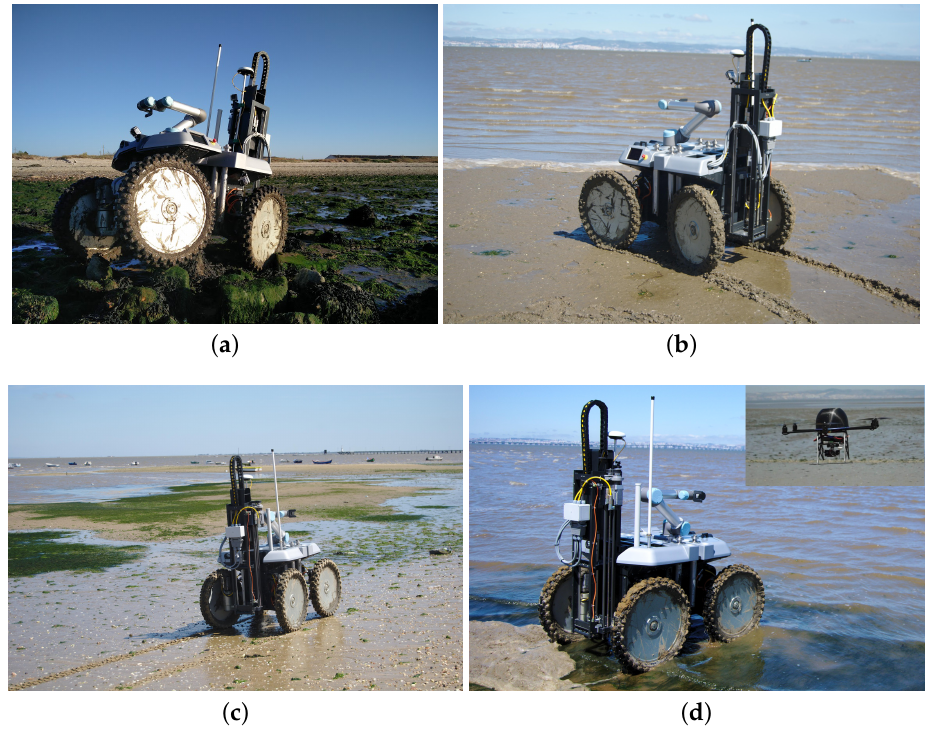
Figure 1. The robotic team in the field trials. The ground vehicle is retrofitted with the drilling tool, which is recharged by a six-DOF arm. The aerial vehicle is equipped with a high resolution camera whose pose is controlled with an active gimbal. ( a ) The ground vehicle over irregular terrain. A passive longitudinal axle allows the robot to follow the terrain’s unevenness. ( b ) The ground vehicle traveling over muddy terrain. ( c ) The ground vehicle over terrain covered with seaweed, small stones and clam shells. ( d ) The ground vehicle traveling over water after three collected samples and the aerial vehicle surveying the field trials